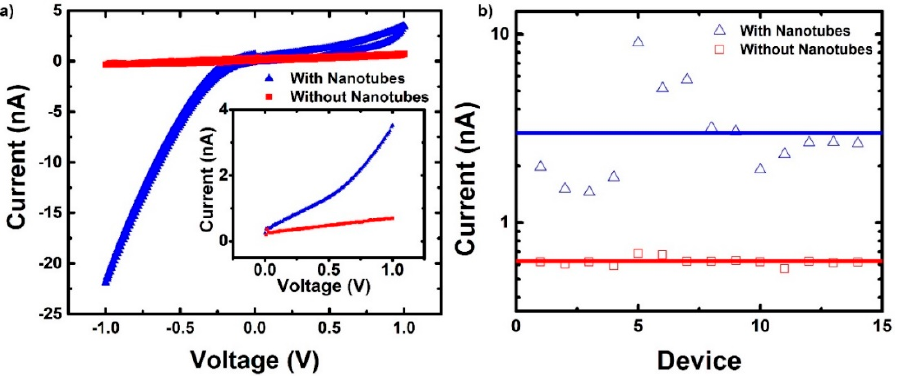
Figure 12. (a ) The average current vs. voltage curve of devices with and without nanotubes. The scan goes from 0 V to 1 V then down to − 1 V and finally back to 0 V. Insert shows the positive range of the voltage from 0 to 1 V. ( b ) The range of currents for 14 devices, with and without nanotubes.